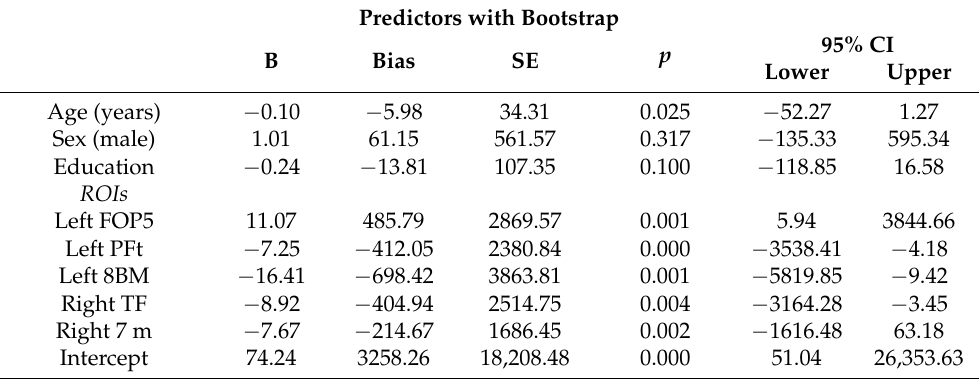
Table 2. Logistic regression model predicting chess expertise based on the fractional dimension of the specific regions of interest (ROI), after controlling for age, sex, and education. Predictors with Bootstrap